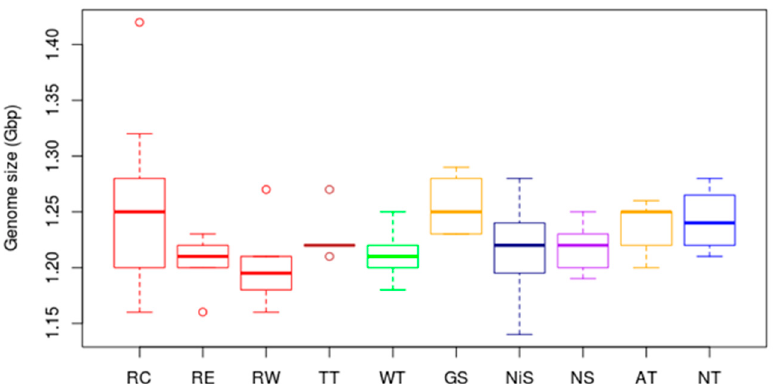
Figure 3. Flow cytometry genome size estimates for different rooibos growth types using silica-dried leaf samples (RC = Red Commercial ( n = 10), RE = Red Escaped ( n = 5), RW = Red Wild ( n = 6), WT = Wupperthal Type ( n = 9), TT = Tree Type ( n = 5), GS = Grey Sprouter ( n = 5), NiS = Nieuwoudtville